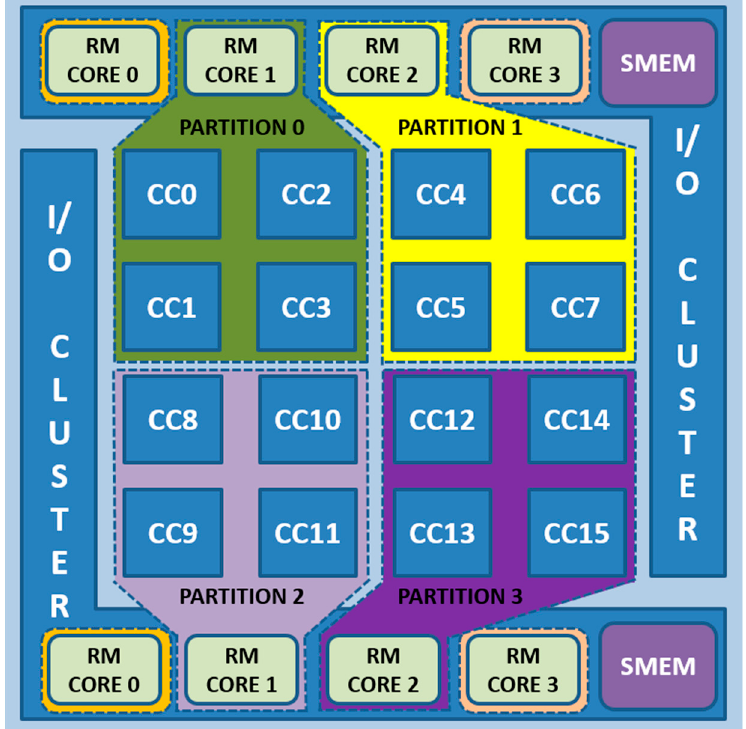
Figure 4. Configuration of the proposed case study for evaluating NMR-MPar approach. RM0 of each IO Cluster coordinates the inter-cluster communications. RM1 and RM2 cores are the masters of each instance and RM3 is the voter.